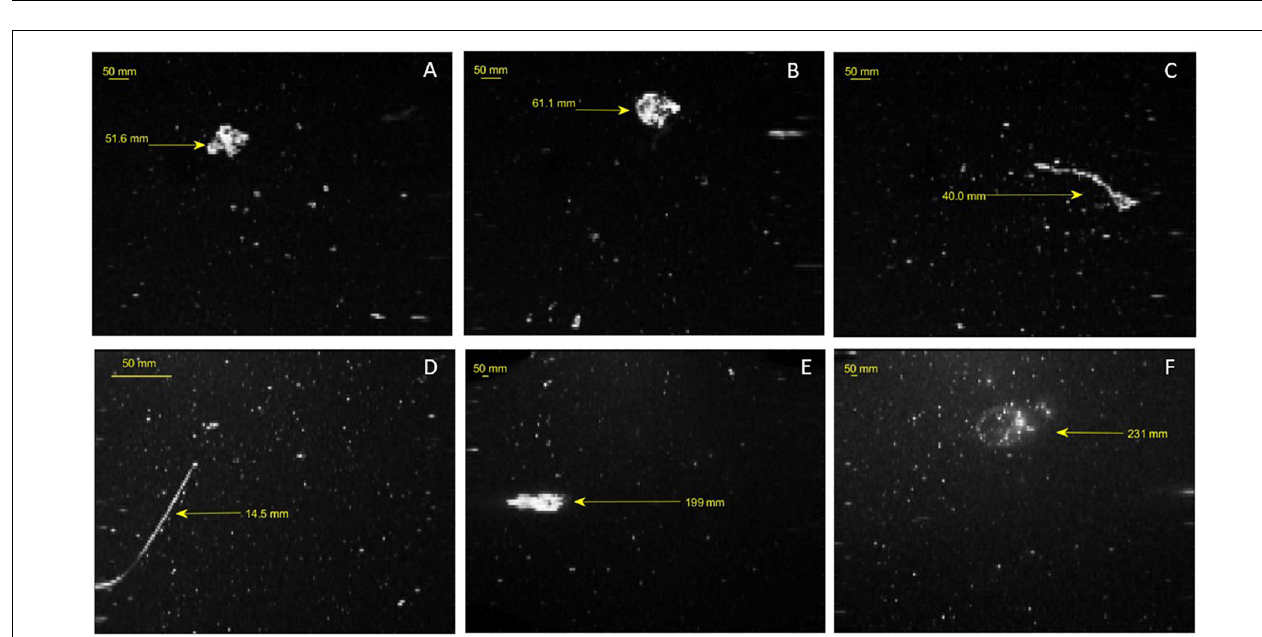
FIGURE 7 | Gray-scale images of large organisms with calculated spherical diameter in mm. Images (A–C) are imaged in dense mode, image (D) represents the densest scan mode (E,F) are imaged in sparse scan mode.